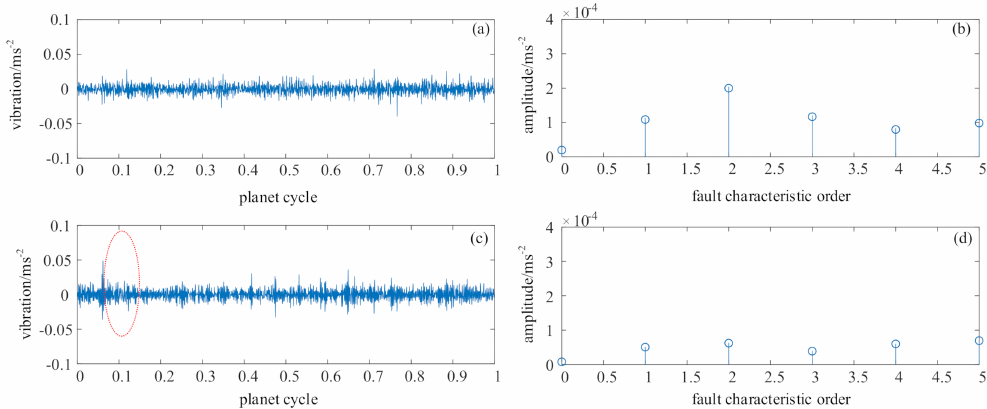
Figure 22. Vibration separation method (VS) signal: ( a ) health condition waveform, ( b ) health condition envelope order spectrum, ( c ) fault condition waveform, and ( d ) fault condition envelope order